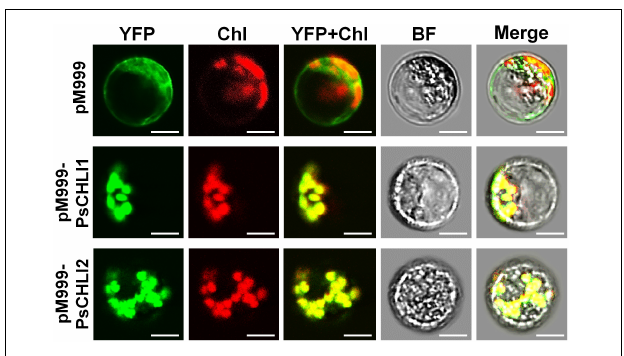
FIGURE 3 | Subcellular localization of PsCHLI1 and PsCHLI2. PsCHLI1 and PsCHLI2 tagged with a C-terminal yellow fluorescent protein (YFP) were transiently expressed under the control of the 35S promoter in pea protoplasts, and images were captured with a laser confocal